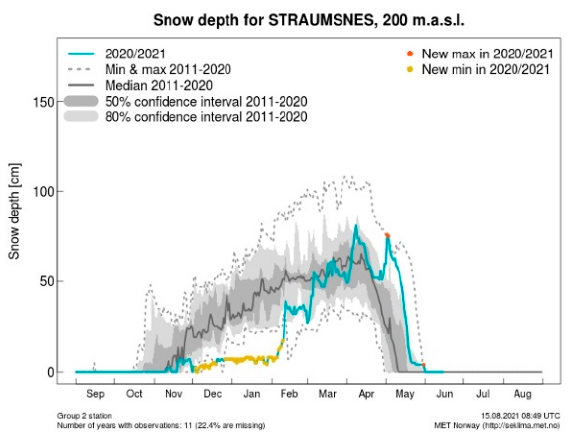
Figure 10. Snow depth in an area close to the WF [55].